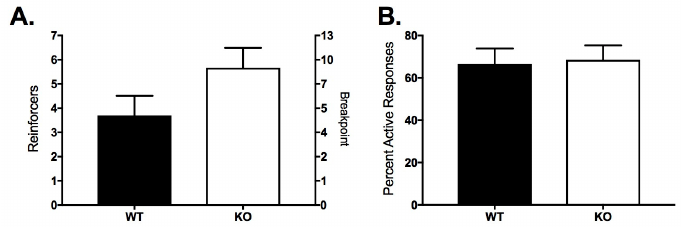
Figure 6. Responses and reinforcers earned during the PR schedule in WT ( n = 9; filled bars) and FAAHKO ( n = 13; open bars) mice. Bars represent mean ± SEM. ( A ) Left y -axis depicts the reinforcers earned; right y -axis depicts the breakpoint reached; ( B ) Mean percent of total responses made in the active port.